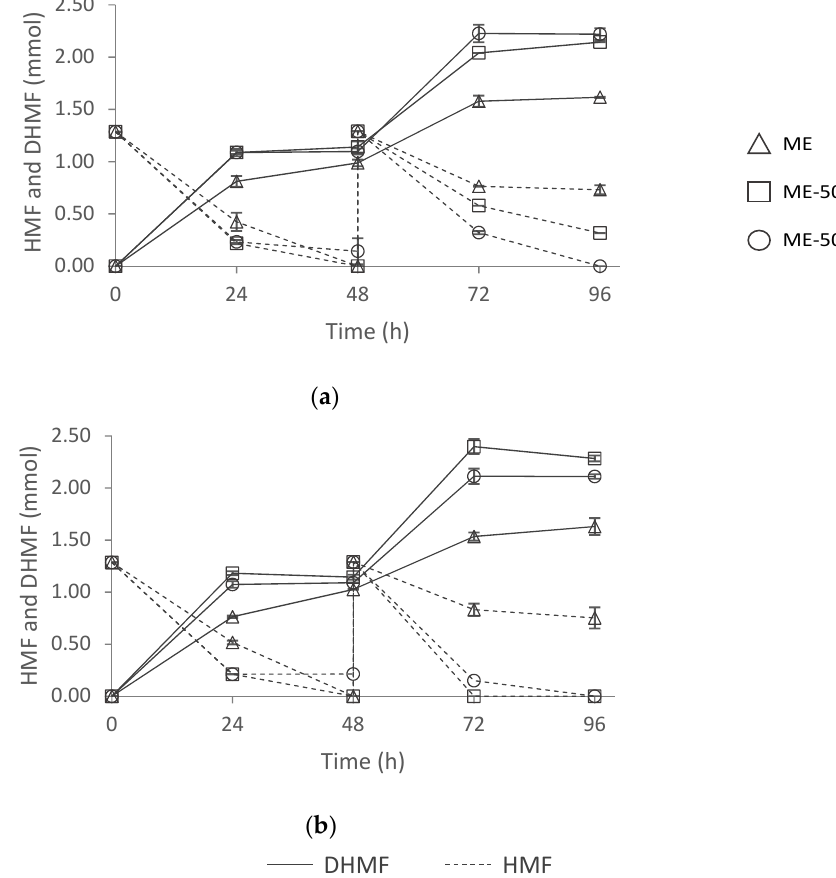
Figure 6. HMF reduction to DHMF with ( a ) discs and ( b ) spores of F. Striatum . ME: malt extract medium, ME-50HA: malt extract medium with 50% of malt extract replaced by Alcalase 2.4 L hy- drolysate, and ME-50HN: malt extract medium with 50% of malt extract replaced by Neutrase 0.8 L hydrolysate.